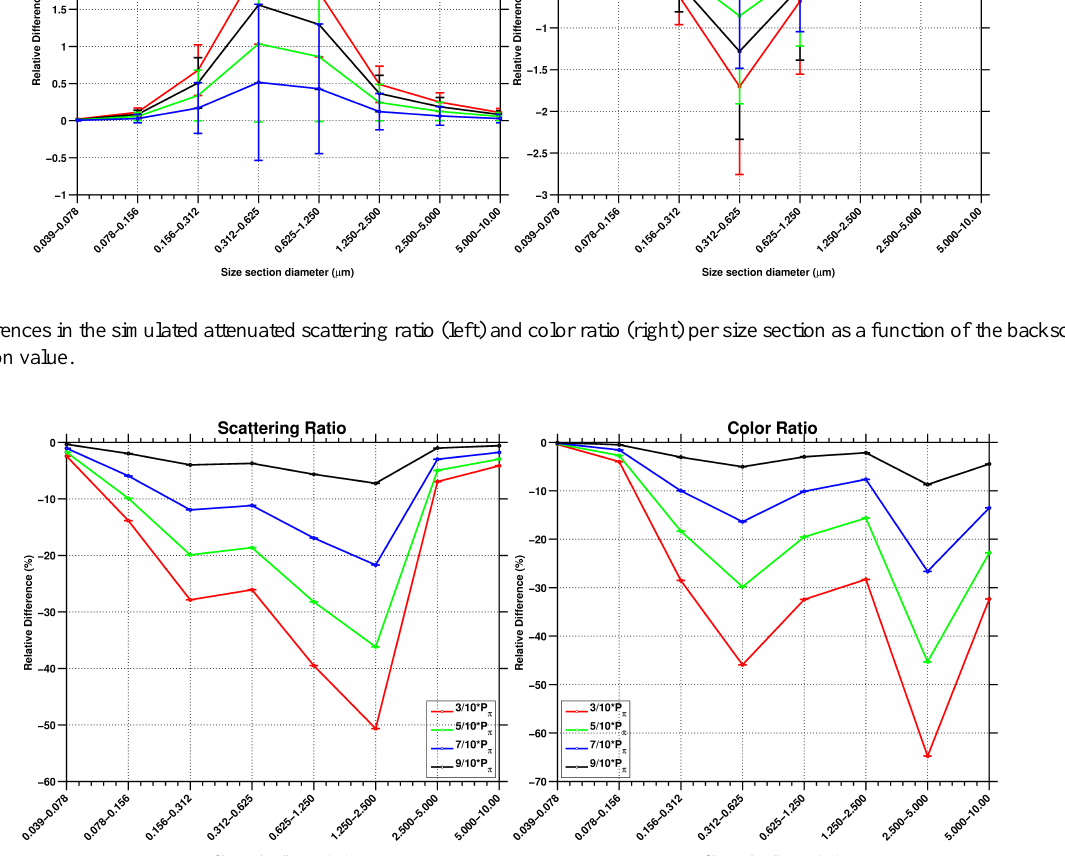
Fig. 7. Differences in the simulated attenuated scattering ratio (left) and color ratio (right) per size section as a function of the multiple scattering parameter η 0.